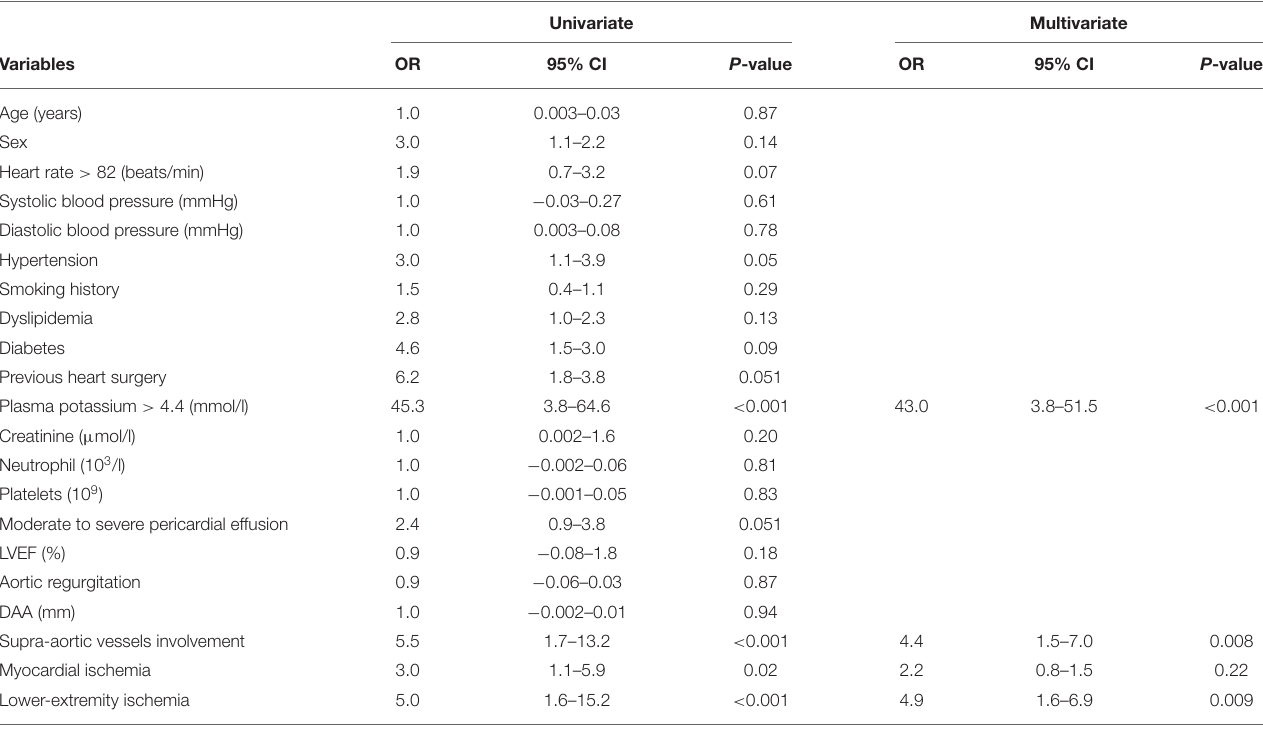
TABLE 4 | Logistic analysis of pre-operative risk factors for mortality in ATAAD. Univariate Multivariate